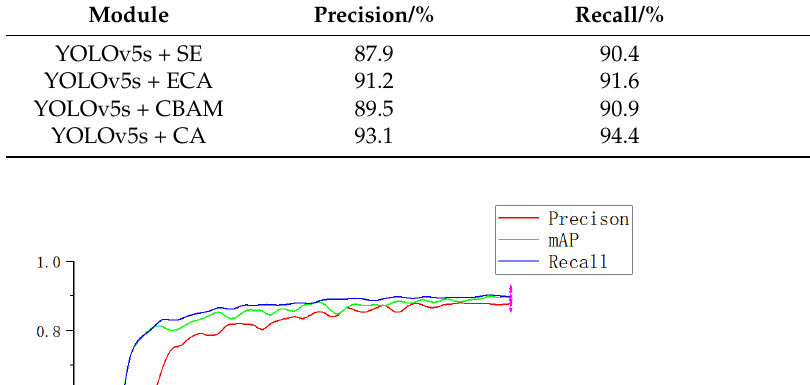
Table 3. Performance comparison of different attention modules.